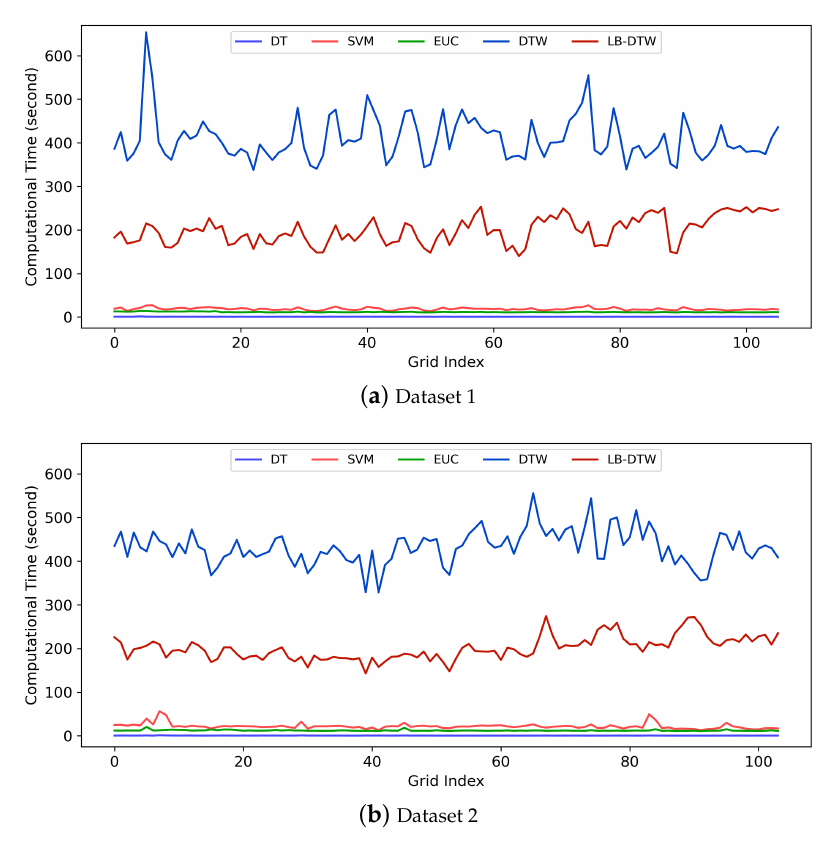
Figure 13. Computational times of each method on all full grids of the two